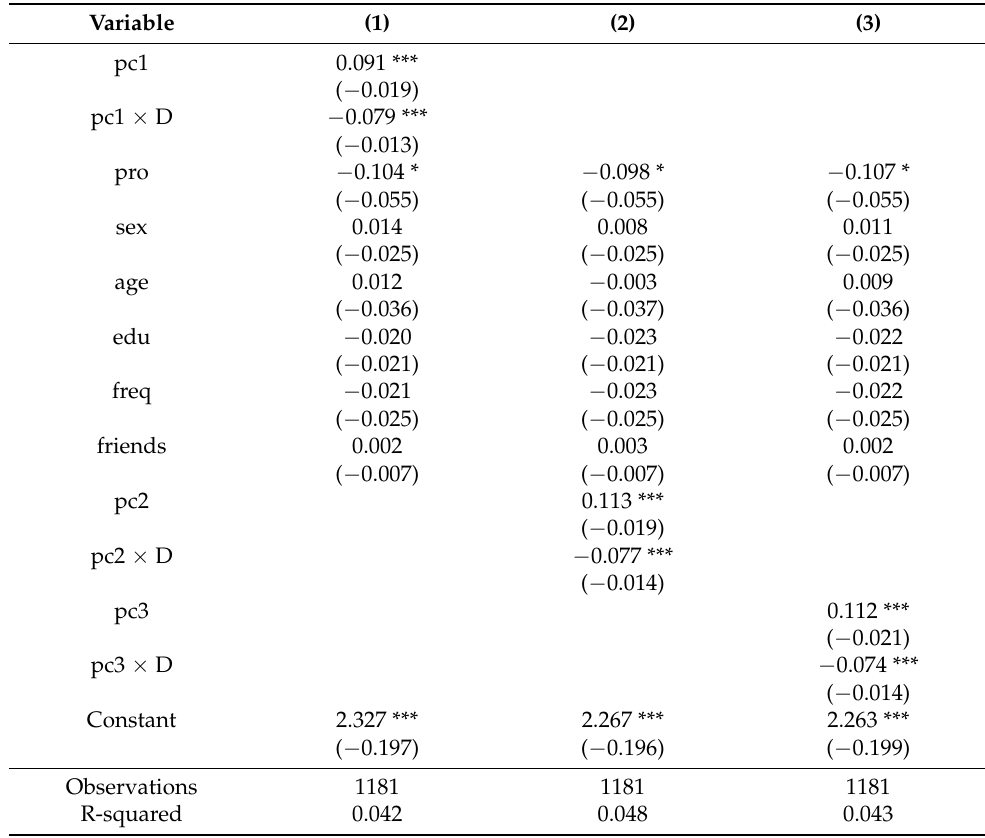
Table 7. The results of